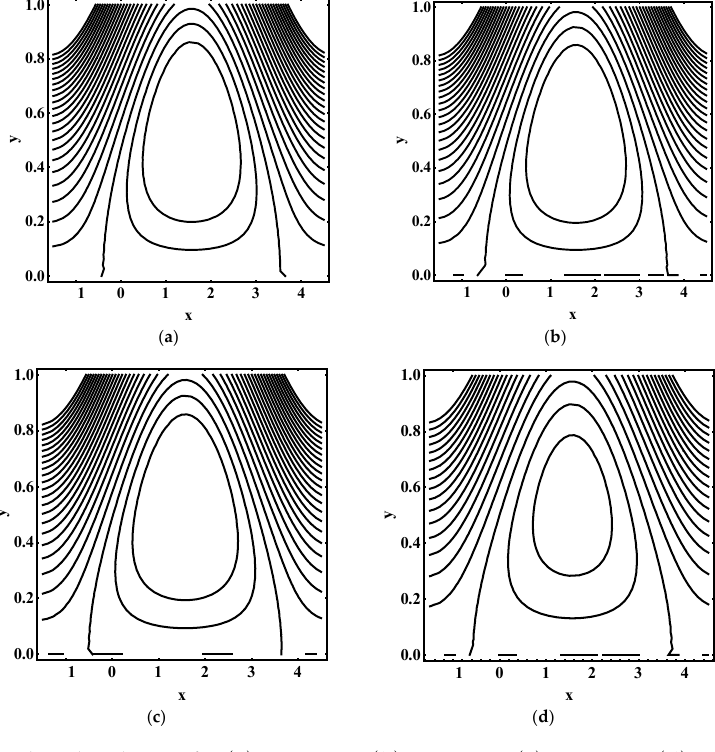
Figure 5. Pressure gradient profile for ().Г ().Θ().  ().  , while other parameters are Г = 0.01, = 0.4,Θ = 0.1,  = 2,  = −1,  = 1.